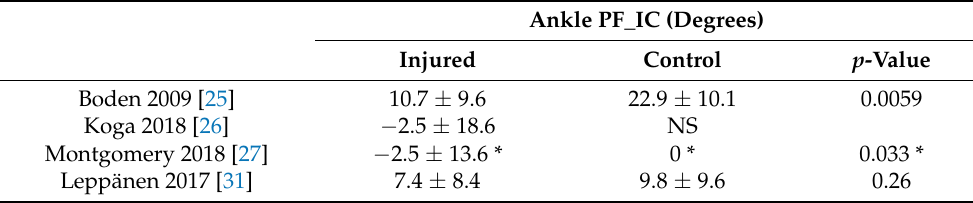
Table 4. Ankle Motion Values of Studies